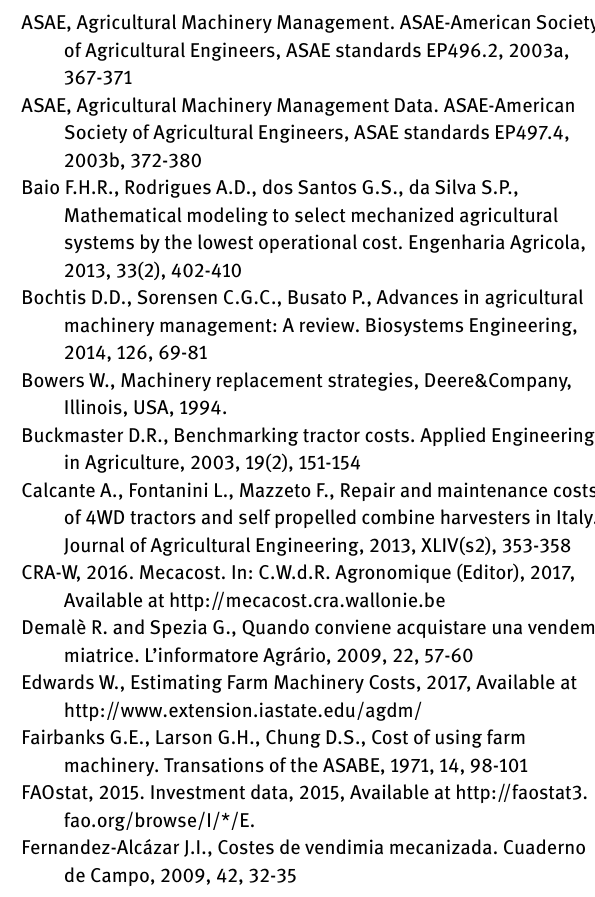
Figure 8: Comparison of fixed costs (FC) and variable costs (VC) estimated by MACHoice and field measurements presented in Pezzi and Martelli, (2015) used as a benchmark for self-propelled (HSP) and Harvest implement (HI) for 124 and 85 ha covered by